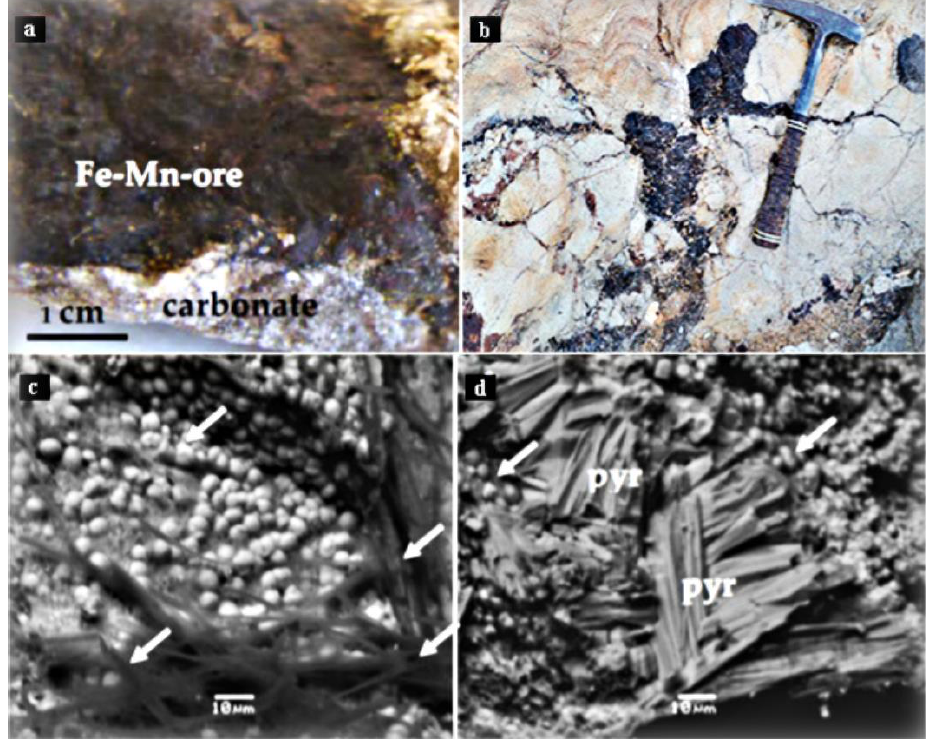
Figure 5. ( a , b ) Photograph of Fe-Mn ore sample hosted in limestone, from the Legrena area, W. Lavrion, Attica. Scanning electron microscope images showing ( c , d ): Consortium of bacteria fossils (white arrows) including abundant sphere or coccus (monococcus, diplococcus, or packets) and fil- aments within a matrix of goethite. Goethite coated spherical fossilized bacteria and fibrous crystals of pyrolusite (pyr) are remarkable. Supergene impregnations with Fe-Mn oxides/hydroxides have been observed in hy- drothermally altered marbles, presenting a red-brown to yellow-brown color in an aban- doned mine located at northern Hymittos Mountain (central Attica), exhibiting a spatial association with unusual silver-rich galena ore (up to 1500 ppm Ag), and As-rich pyrite (up to 3.9 wt% As) in the core of zoned pyrites. This mineralization is hosted in mylonitic marbles that have been affected by brittle-ductile deformation which is associated with the West Cycladic Detachment System [34]. These authors provided isotope data and con- cluded similarity to the low-temperature carbonate replacement style mineralization in Kamariza, Lavrion mine. Specifically, the isotopically light ( − 11.2 to −12.2‰) values for δ 34 S from galena suggest a sedimentary component to the ore fluid, derived probably from leaching of the meta-sedimentary (calc-mica schists) wall rocks. In addition, the C and O isotopic composition of the carbonate wall rock distal to the orebody is typical of marine carbonates, whereas hydrothermal brown calcite and dolomite are dominated by an ex- ternal, light C source [34].